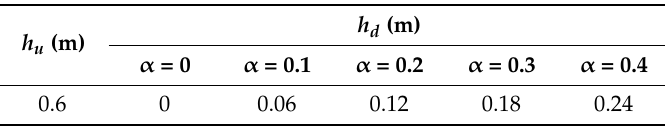
Table 1. Experimental conditions.